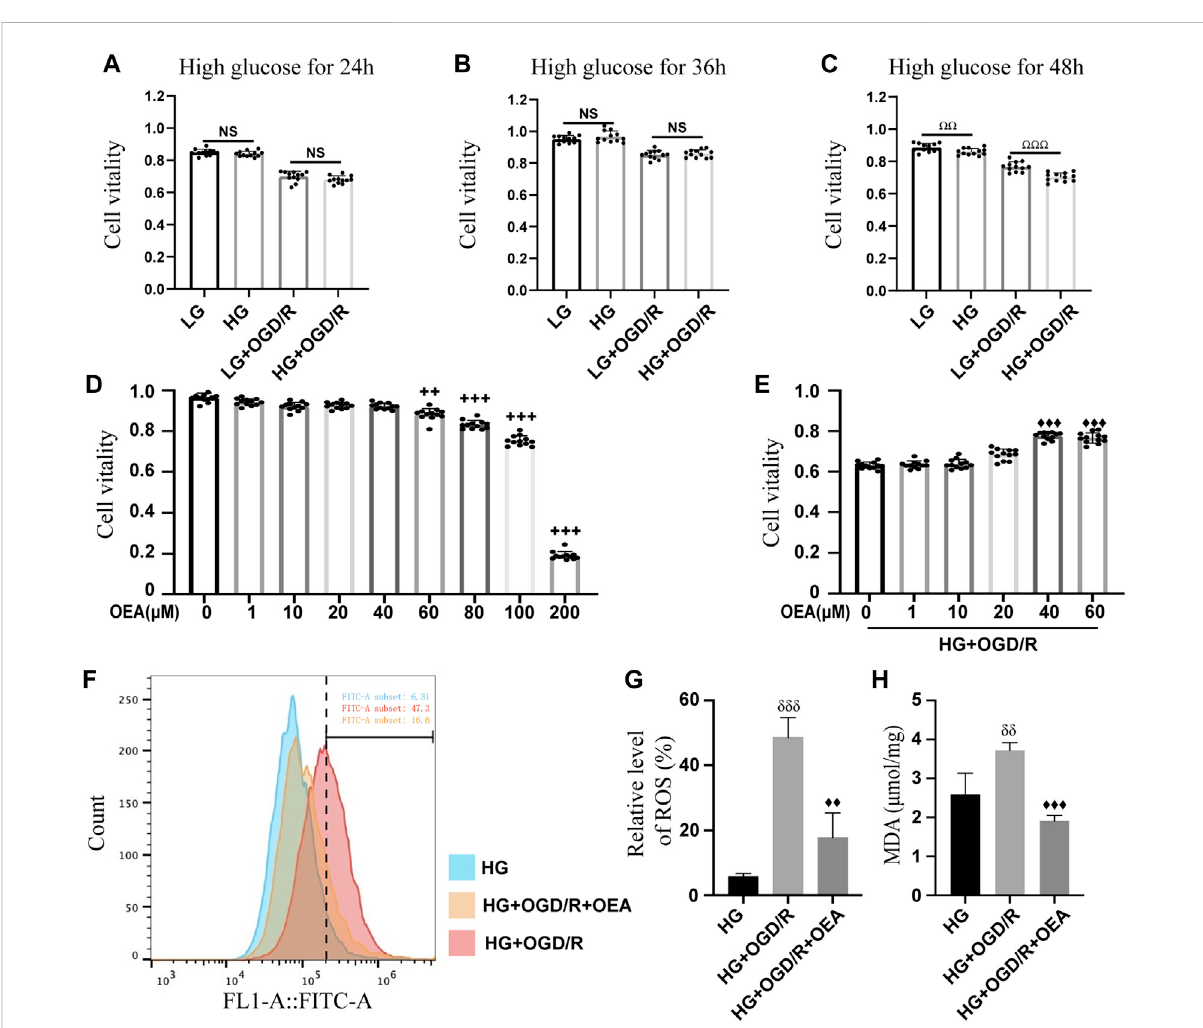
FIGURE 3 In vitro protective effects of OEA on the model. (A – C) CCK-8 assay results showed the viability of H9C2 cells treated with OGD/R at different time points after high glucose induction ( n = 12). (D) The CCK-8 assay data revealed the viability of H9C2 cells after 24 h of treatment with different concentrations of OEA ( n = 6). (E) The viability of H9C2 cells was analyzed by CCK-8 assay after treatment with different concentrations of OEA invitro with high glucose andOGD/R( n =12). (F,G) The ROS level ineachgroup after OGD/Rand OEA(40 μ M)treatment was detectedby fl ow cytometry ( n = 3). (H) MDA level in each group after high glucose and OGD/R and OEA (40 μ M) treatment ( n = 3). Data were expressed as mean ± SEM, ΩΩ P < 0.01, ΩΩΩ P < 0.001, the control group was shown in the horizontal line label; ++ p < 0.01, +++ p < 0.001 vs. OEA 0 μ M group; ◆◆ p <